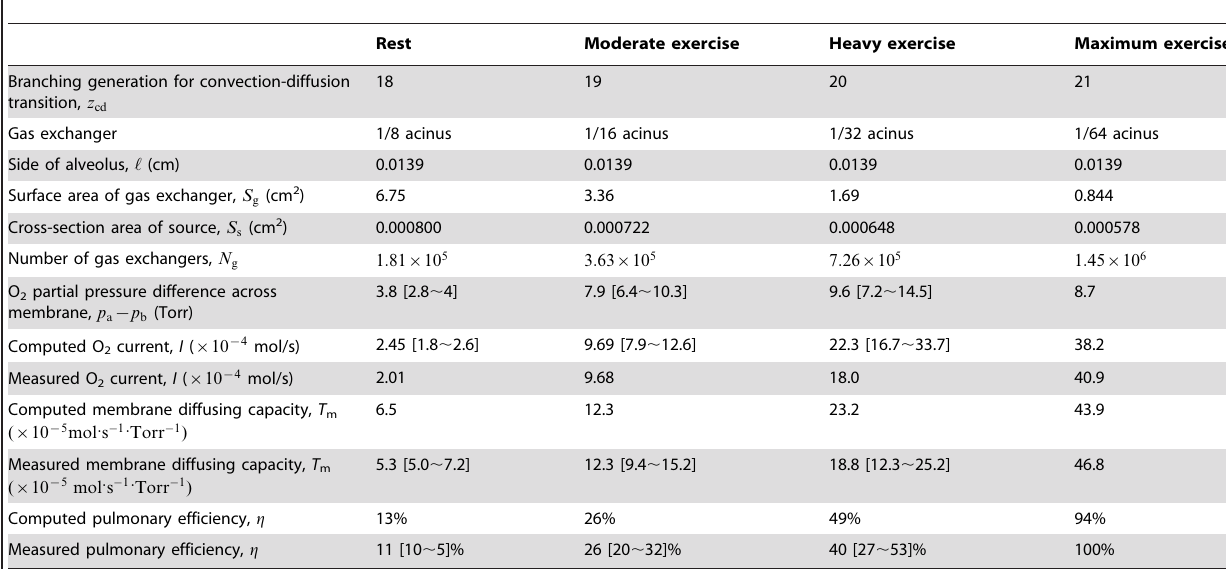
Table 2. Structural and physiological data to compute O 2 currents and compare computed and experimental values.